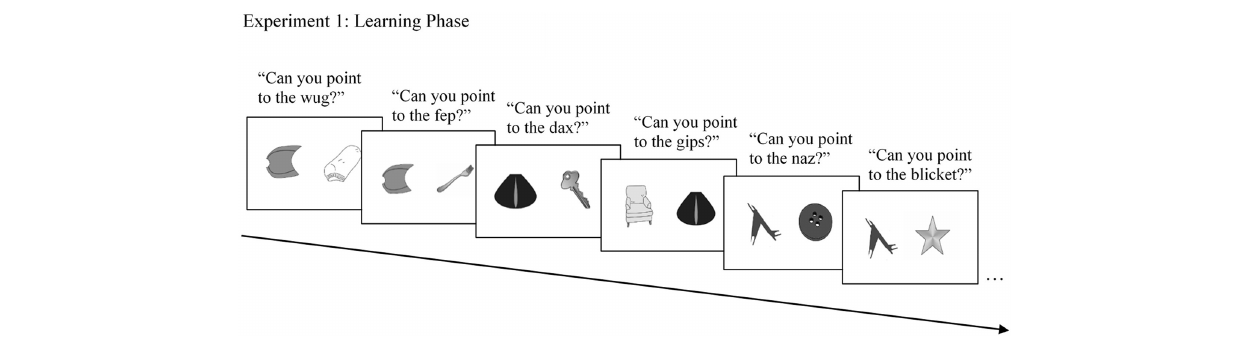
FIGURE 1 | Examples of stimuli used in the learning phase of Experiment 1. In Experiment 1, participants were presented with two novel labels in two consecutive learning trials for the same target novel object, along with familiar objects as foils. This allowed participants a first opportunity to use MEB, and immediately following, another situation of referential ambiguity when children were unlikely to use